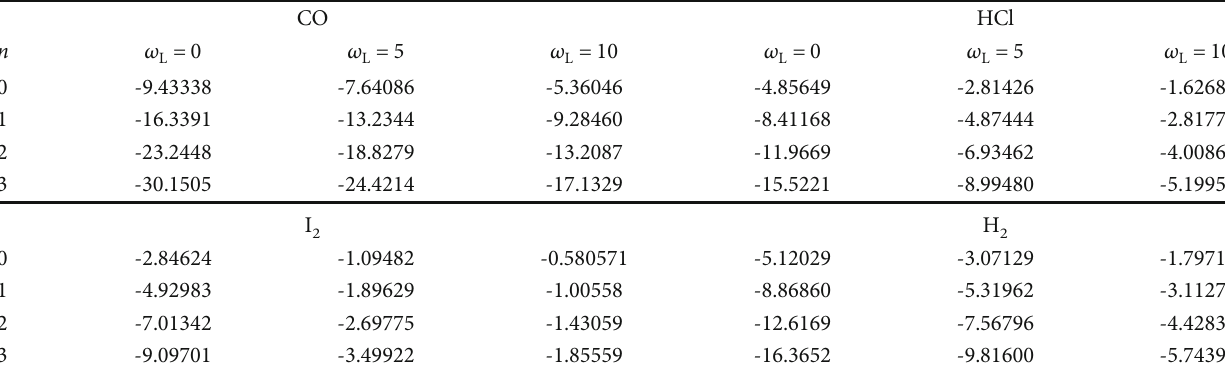
, and H molecules bounded by the isotropic oscillator plus inverse quadratic potential for 2 2 with g = m = 1 . L